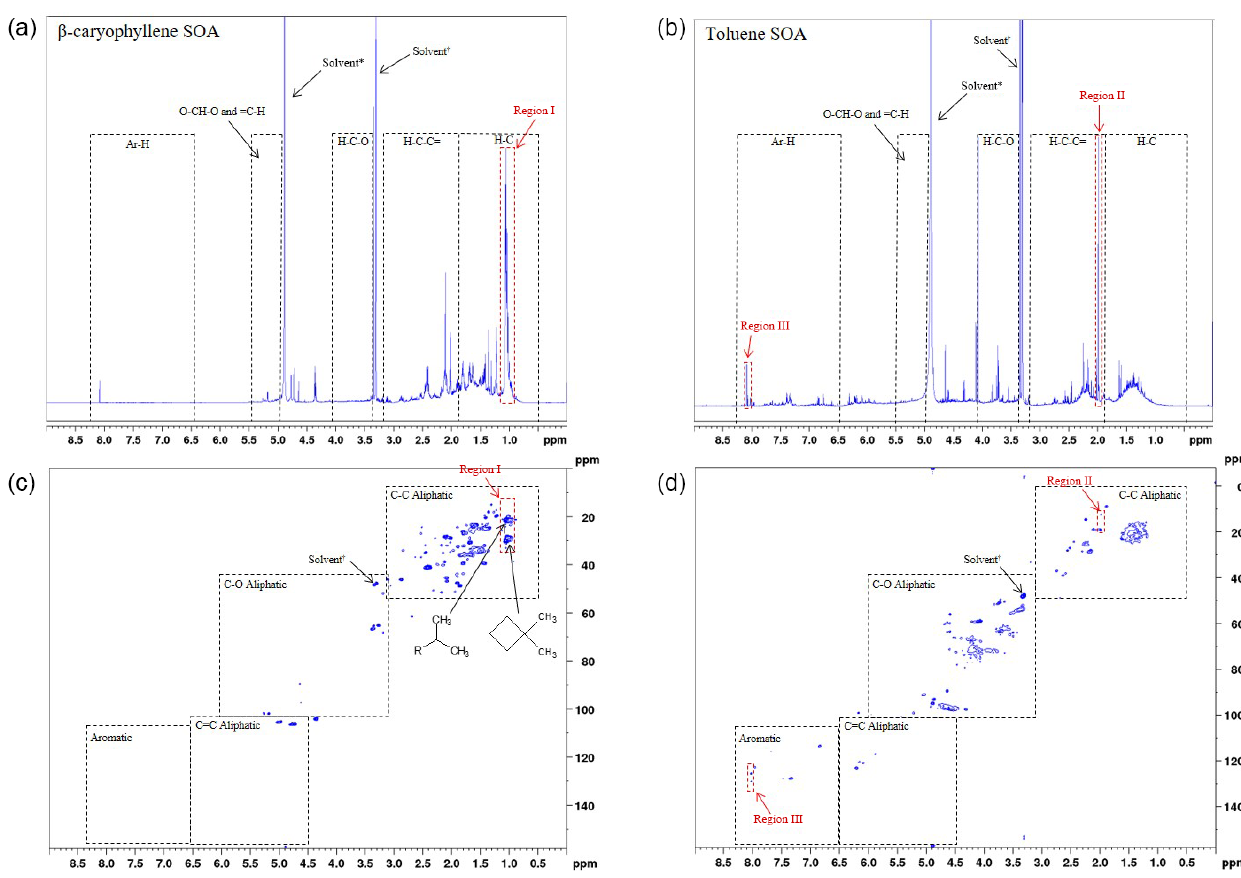
Figure 6. 1 H and 1 H- 13 C HSQC NMR spectra of β -caryophyllene ( a and b , respectively) and toluene ( c and d , respectively) SOA formed at 55% relative humidity with a VOC / NO x ratio of 13 (exps. 31 and 36, respectively; see Table 1). The proton spectral regions, as defined in Decesari et al. (2000, 2001), are shown in the 1 H NMR spectra as dashed black lines. The spectral regions shown in the 1 H- 13 C HSQC NMR spectra have been adapted from Chen et al. (2016); see the text for further